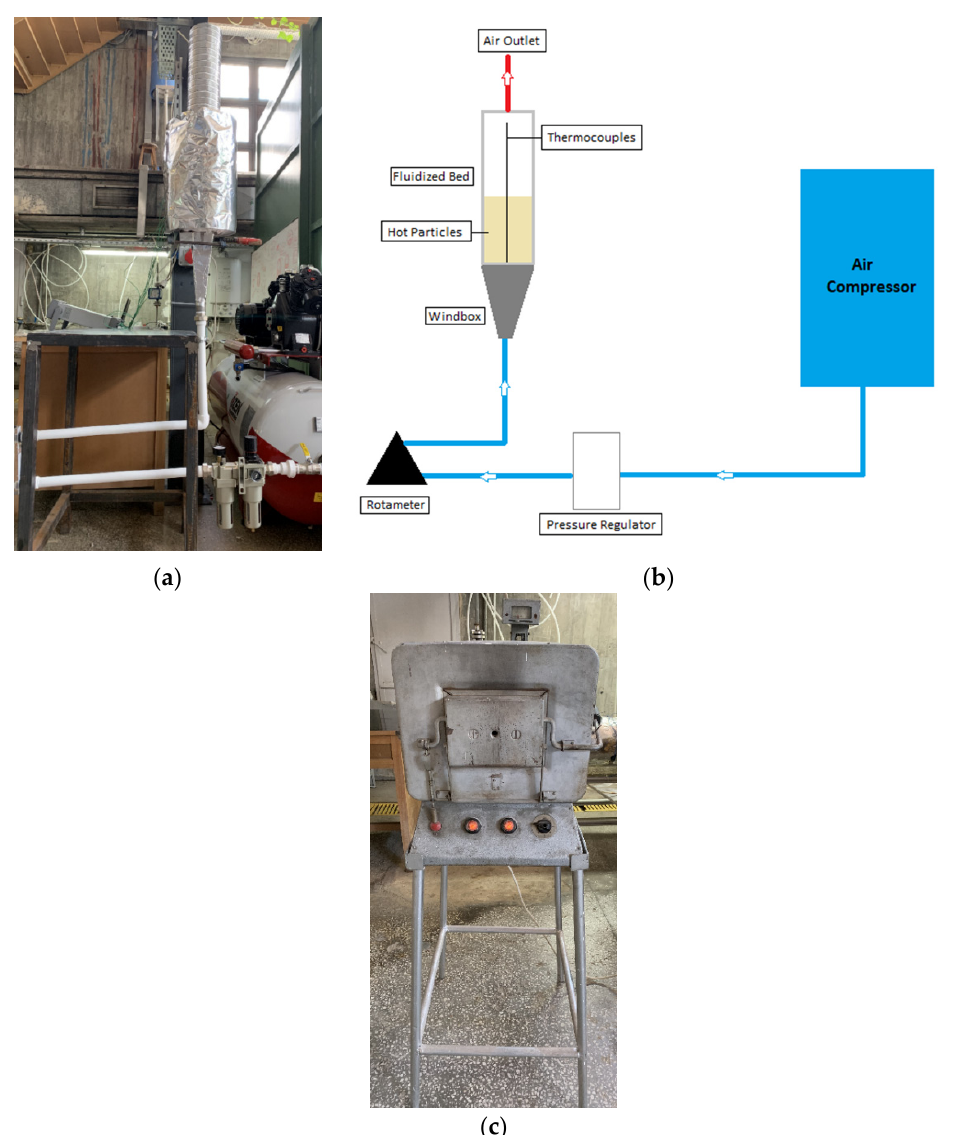
Figure 2. ( a ) Snapshot of the thermal experimental setup; ( b ) diagram of the operation in the thermal experimental setup; ( c ) the furnace used in the experiment.